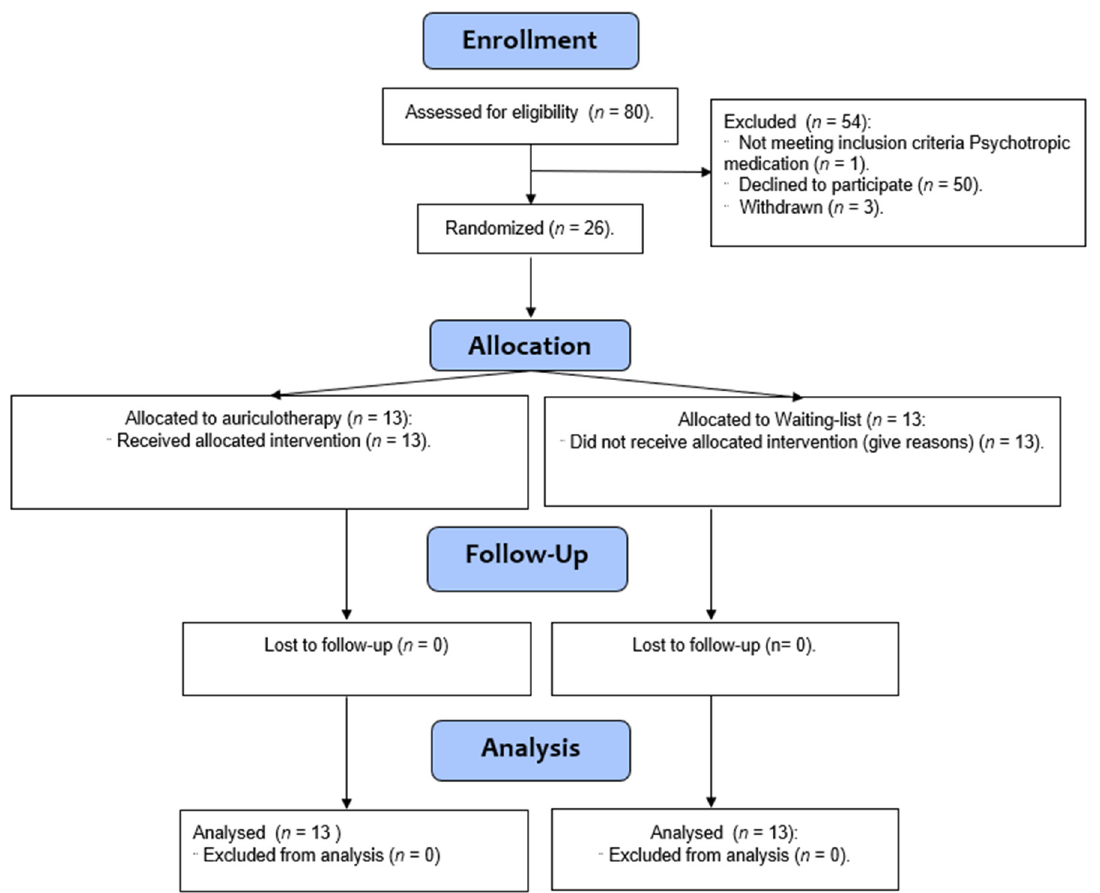
Figure 1. Study flow diagram based on Consolidated Standards of Reporting Trials (CONSORT) guidelines.